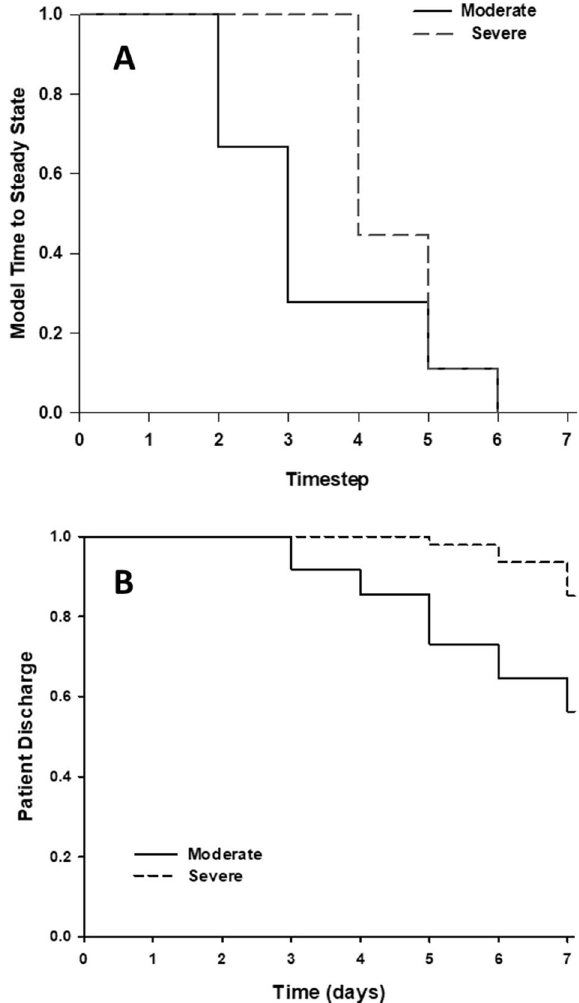
Figure 6. Logical model captures differences in patient discharge in Moderate vs Severe Injury patients. Kaplan–Meier style survival curve with endpoint as steady state (simulations, Panel A ) or patient discharge (patients, Panel B ). Simulations of moderate injury reach steady state sooner than severe injury (top panel). Similarly, patients with moderate injury are discharged sooner than severely injured patients (bottom